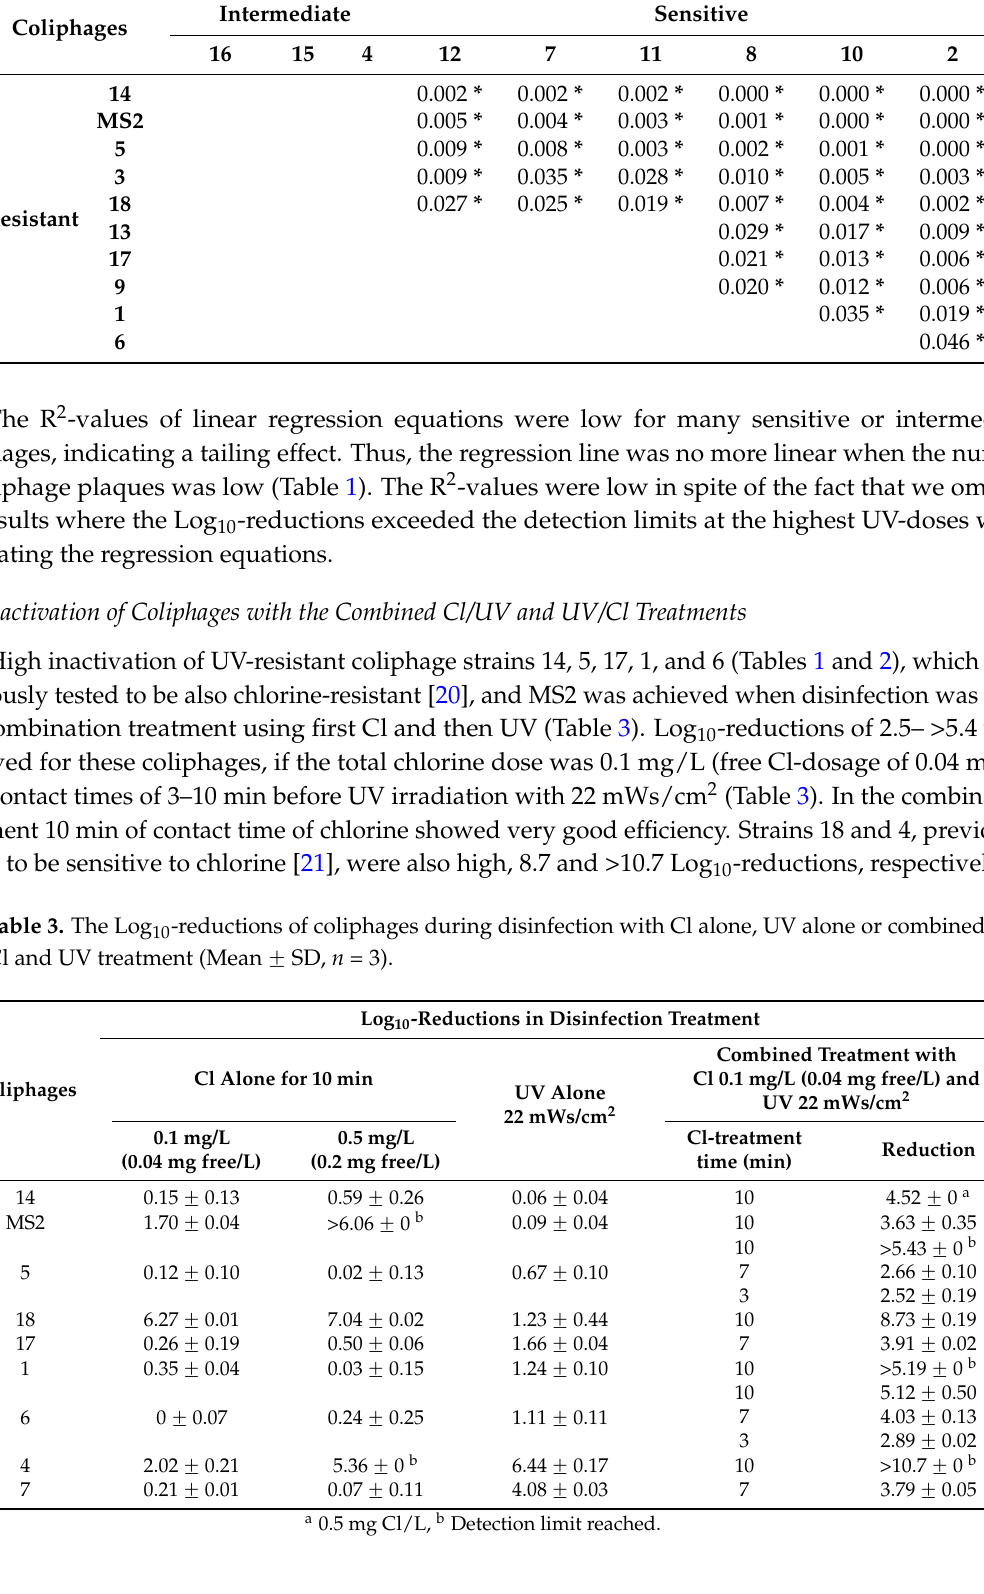
Table 2. Grouping of coliphage strains to UV-resistant, -intermediate and -sensitive based on statistically significant differences between the slopes of linear regression equations (k = Log 10 -reduction/UV dose) of the strains ( * p < 0.05, Kruskall-Wallis test). The table shows only the statistically significant p -values. Intermediate Sensitive Coliphages